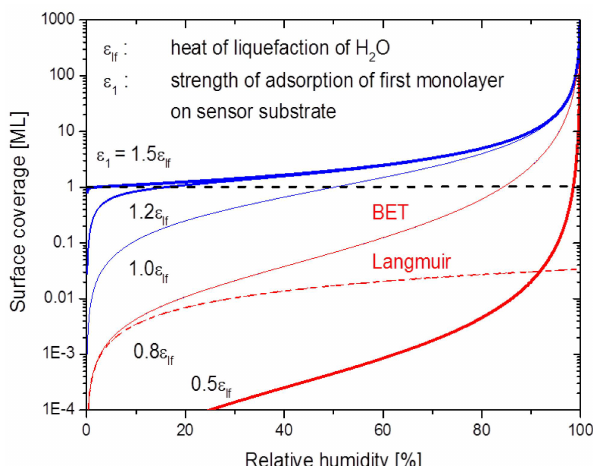
Figure 6. BET coverage in monolayers (ML) at 293 K as a function of the relative humidity. The degree of BET adsorption critically depends on the strength of adsorption ε